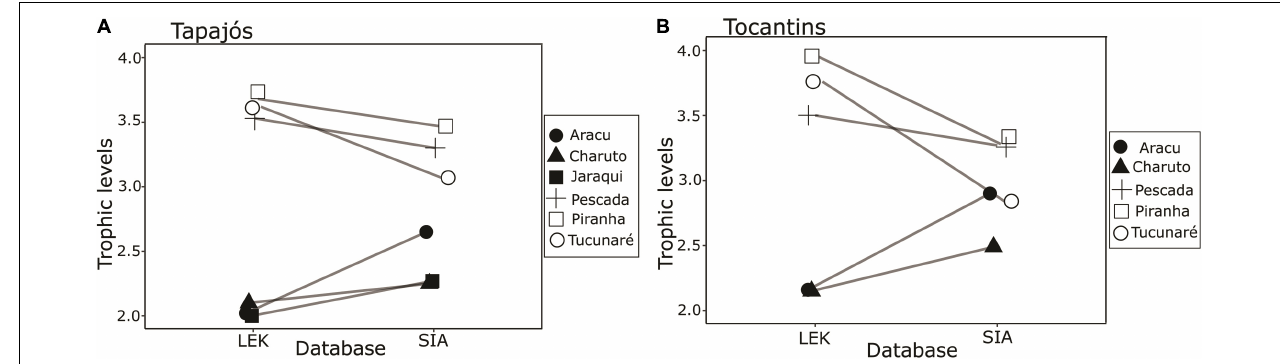
FIGURE 2 | Paired comparison between trophic levels of fish species based on fisher’s knowledge (LEK) and stable isotope analysis (SIA) in the (A) Tapajós river ( t = –0.58, df = 5, p = 0.96) and (B) Tocantins river ( t = 0.48, df = 4, p = 0.66). The fish species analyzed were Aracu ( Leporinus fasciatus ), Charuto ( Hemiodus unimaculatus ), Jaraqui ( Semaprochilodus spp.) except in the Tocantins river, Pescada ( Plagioscion squamosissimus ), Piranha ( Serrasalmus rhombeus ), and Tucunaré ( Cichla pinima ).